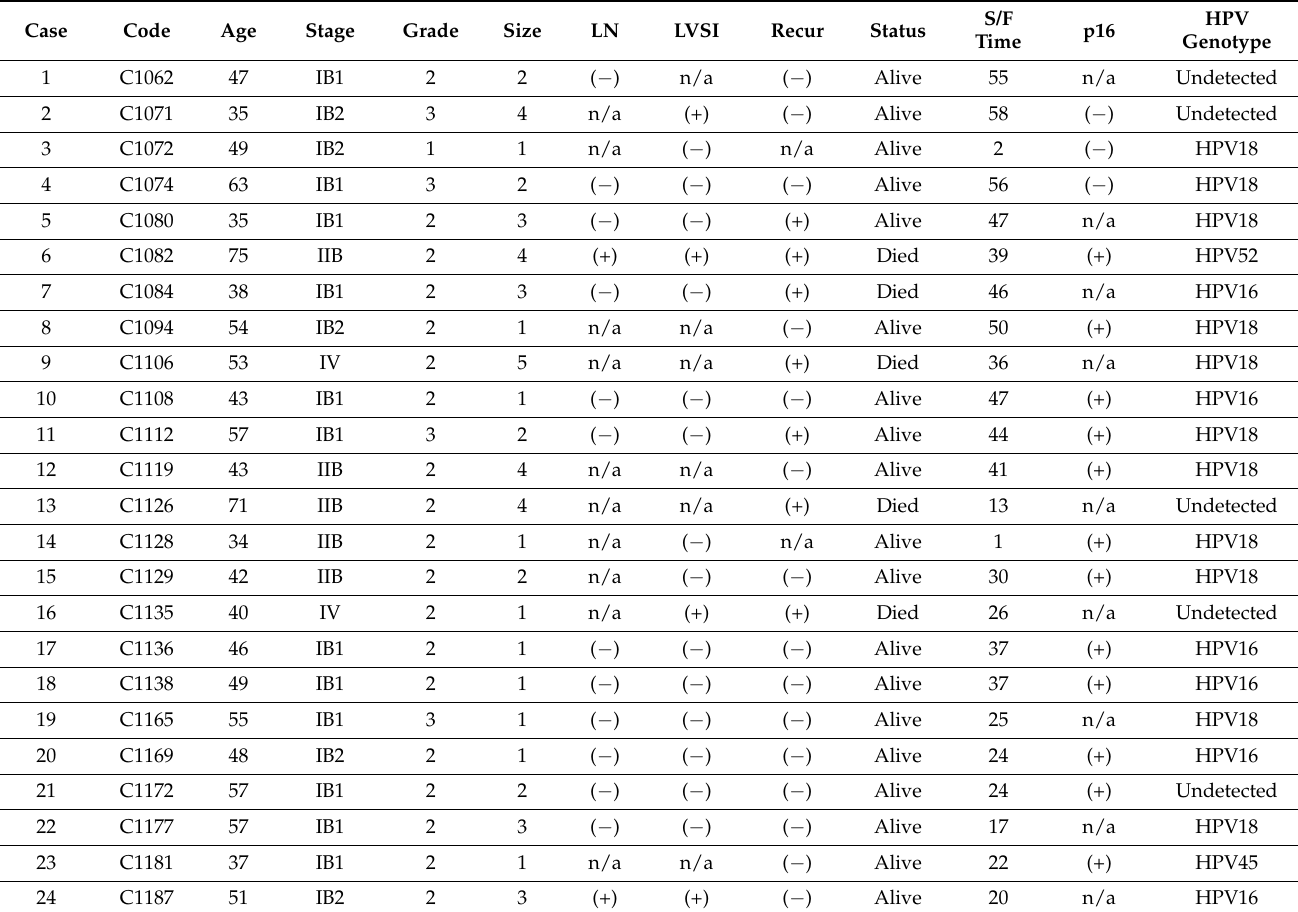
Table 1. Clinicopathological features of cervical